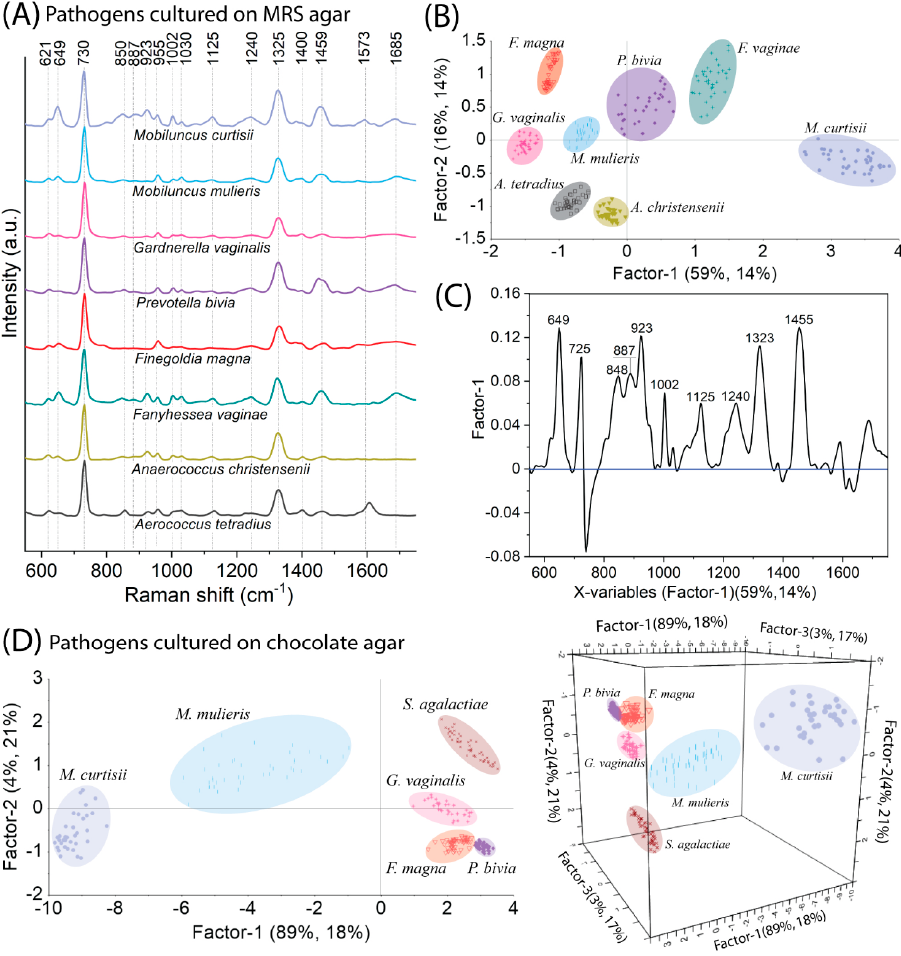
Figure 4. The SERS spectra ( A ) and PLSR results in the form of score plot ( B ) and X − loadings plot ( C ) for the most prevalent pathogenic bacteria cultivated on MRS agar, and PLSR results in the form of score plots 2D and 3D ( D ) for pathogenic bacteria cultivated on chocolate agar. score plots 2D and 3D ( D ) for pathogenic bacteria cultivated on chocolate